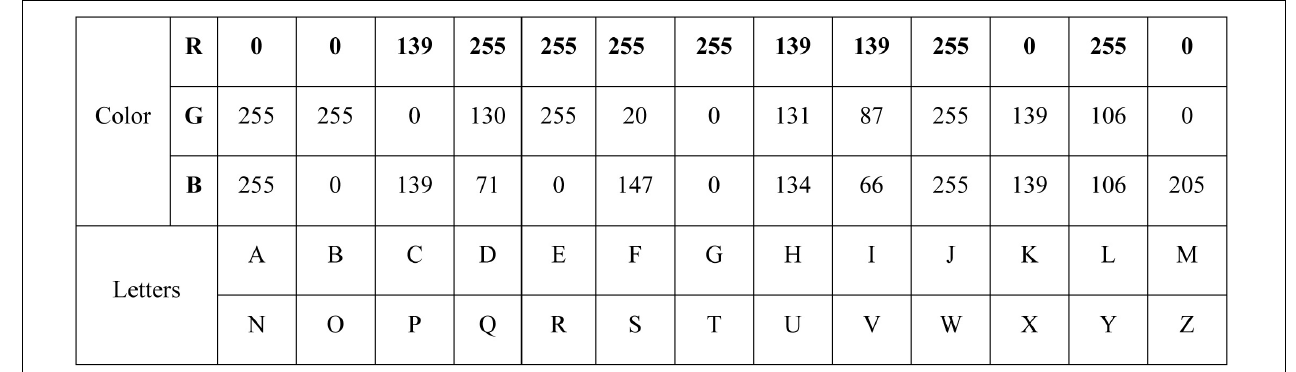
FIGURE 2 | The color of each letter.